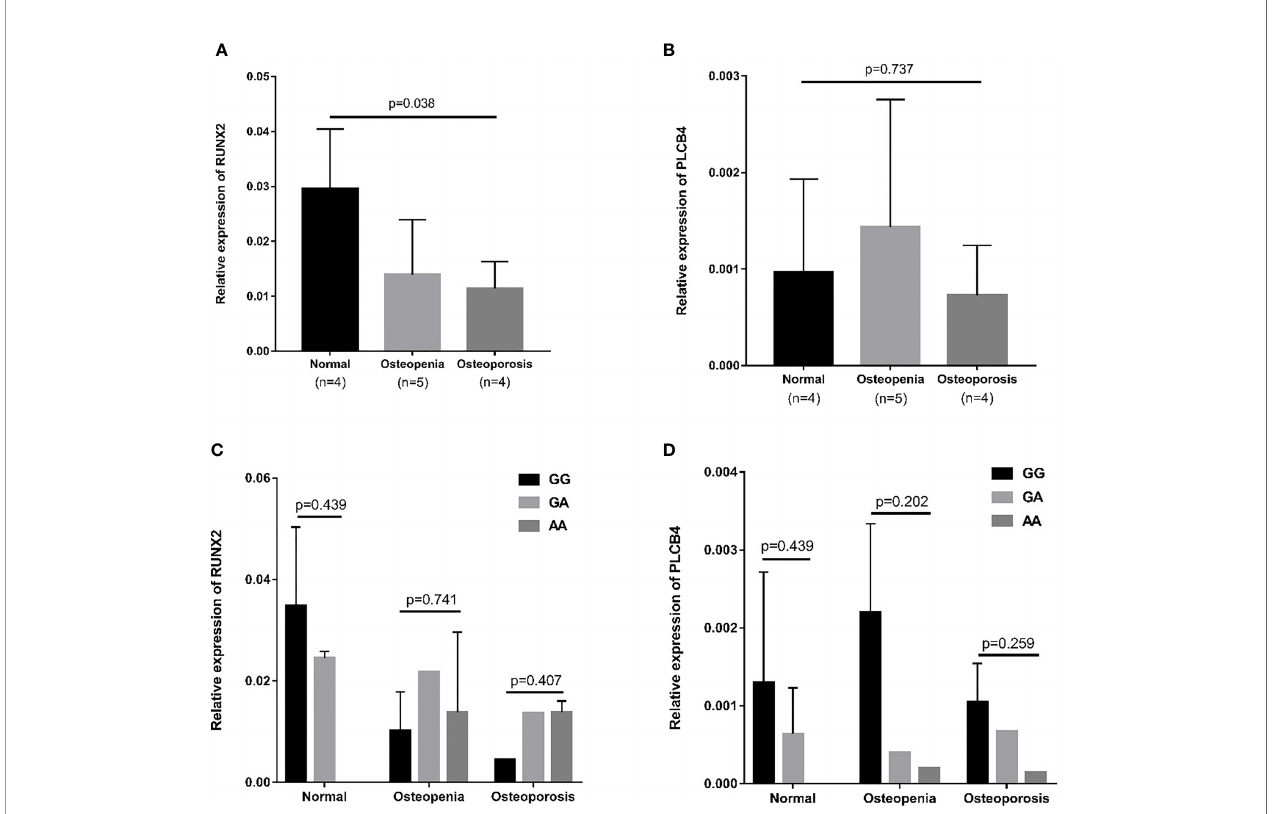
FIGURE 3 | Relative mRNA expression in osteopenia, osteoporosis, and normal groups. (A) Relative mRNA expression of RUNX2: osteoporosis patients had lower mRNA expression than normal group (p = 0.008). (B) Relative mRNA expression of PLCB4: there is no difference in mRNA expression among the 3 groups (p = 0.737). The effect of the rs6086746 genotypes on the (C) RUNX2 and (D) PLCB4 mRNA expression level in the normal, osteopenia, and osteoporosis patient groups. There was no association between rs6086746 genotype and mRNA expression in each group. RUNX2, RUNX family transcription factor 2; PLCB4, phospholipase C beta